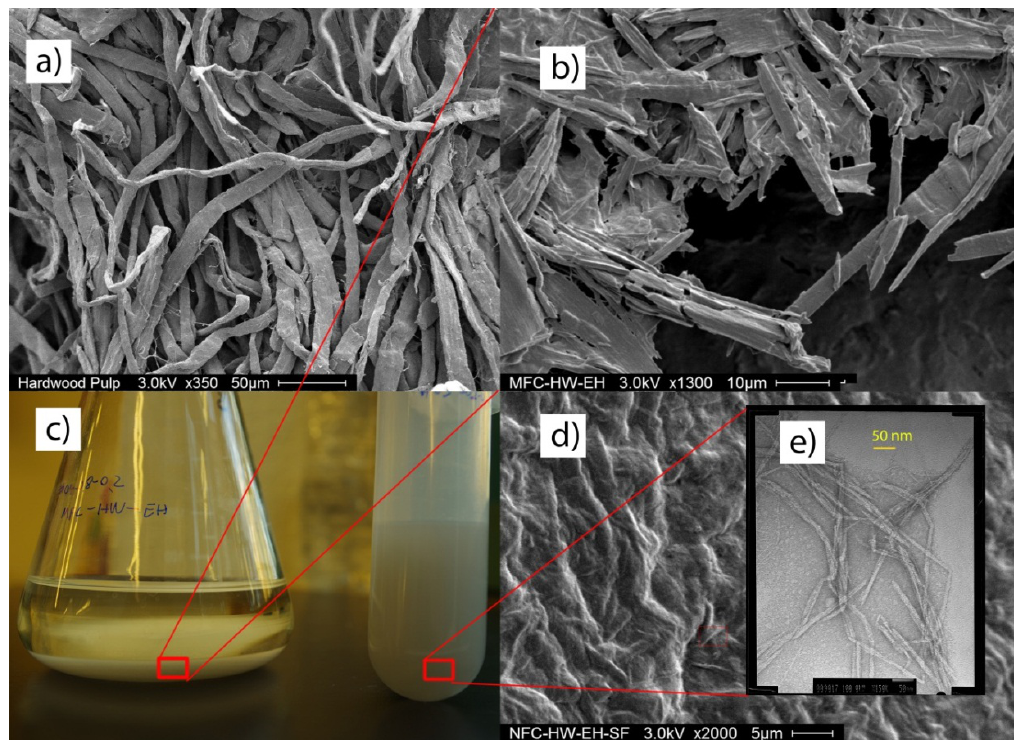
Figure 7. SEM micrograph of hardwood pulp ( a ) before and ( b ) after enzymatic hydrolysis treatment (MFC-HW-EH); ( c ) left: MFC-HW-EH in aqueous suspension and right: NFC-HW-EH-SF in water suspension; ( d ) SEM micrograph of air-dried NFC-HW-EH-SF and ( e ) TEM micrograph of